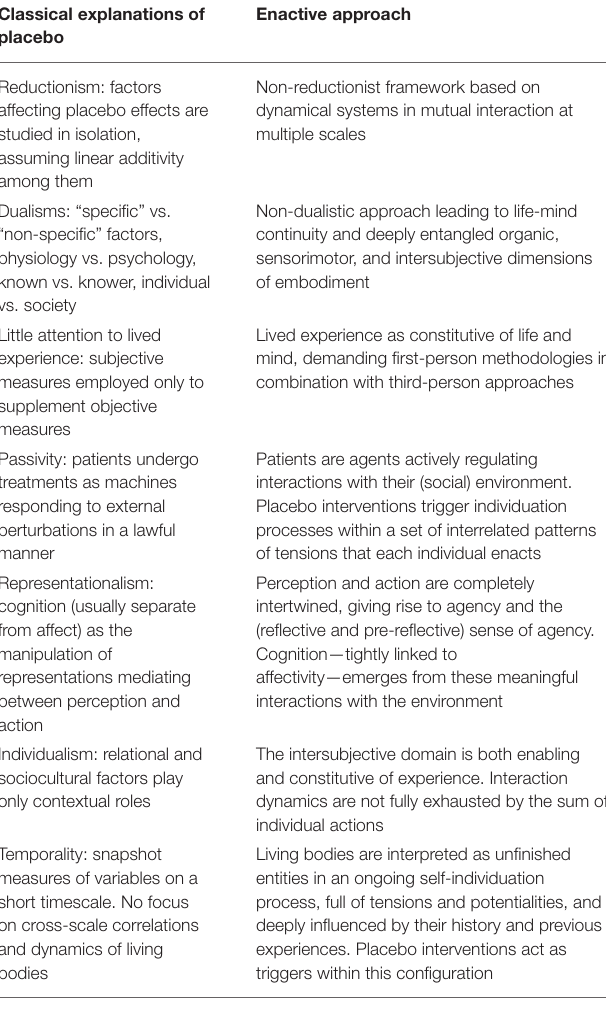
TABLE 1 | Comparison of underlying assumptions in classical explanations of placebo phenomena and the enactive approach. Classical explanations of Enactive placebo